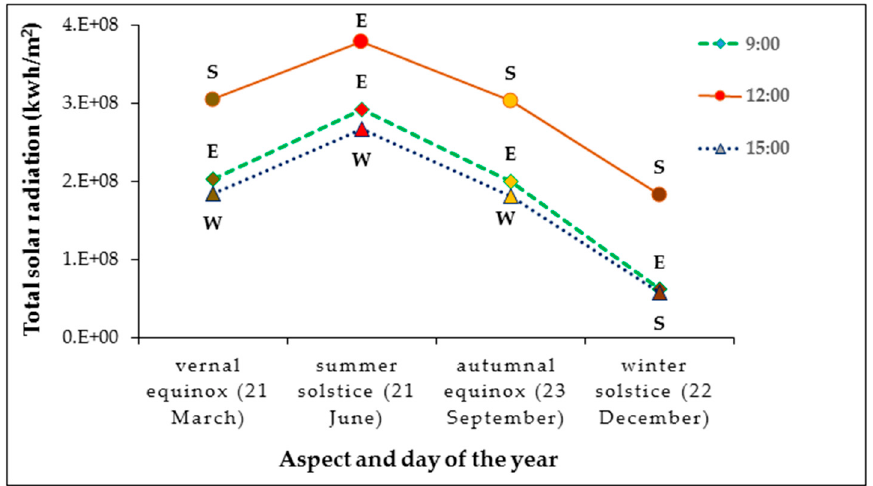
Figure 13. Total solar radiation distribution (including all slope categories), E (East), W (West), and S (South).